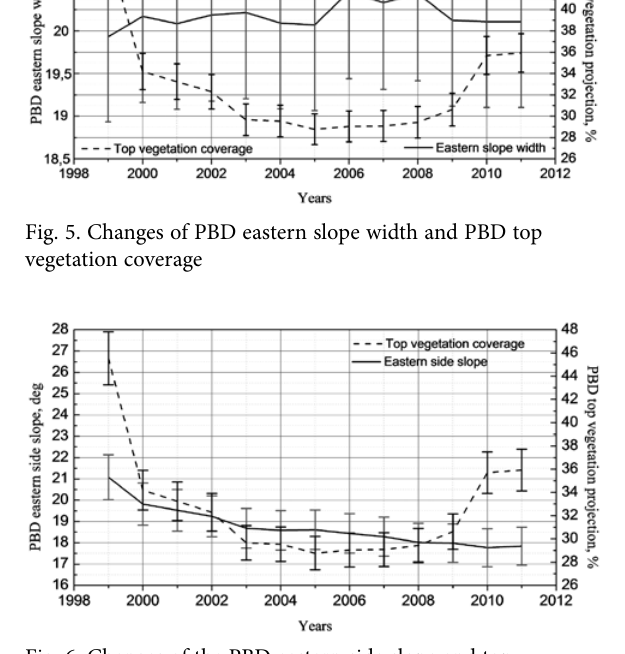
Fig. 6. Changes of the PBD eastern side slope and top vegetation